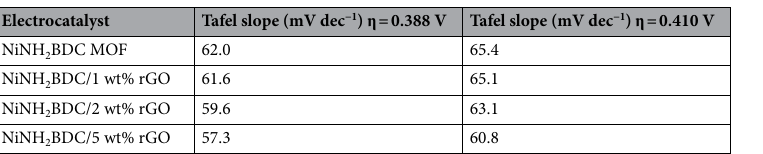
Table 3. The Tafel slope values of NiNH 2 BDC MOF/1, 2, 5 wt% reduced graphitic carbon hybrids at high and low overpotential.